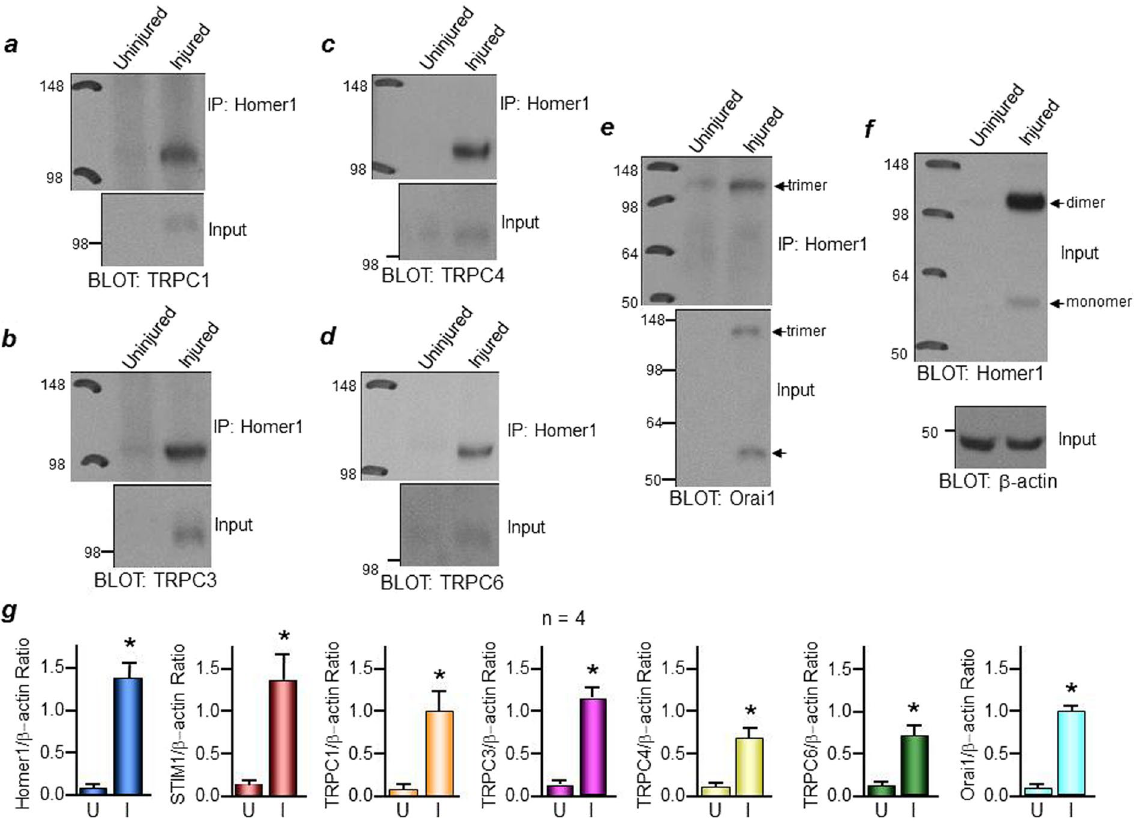
Figure 2. Increased protein expression and interaction of TRPC channels and Orai1 with Homer1 in neointima from balloon-injured rat carotid artery. Protein expression levels of Homer1 along with TRPC1, TRPC3, TRPC4, TRPC6, and Orai1 ( a – f ) are upregulated in injured (media + neointima) compared to uninjured VSMCs. Co-immunoprecipitation assay using anti-Homer1 antibody to immunoprecipitate Homer1 shows that Homer1 interacts with ( a ) TRPC1; ( b ) TRPC3; ( c ) TRPC4; ( d ) TRPC6; and ( e ) Orai1 in injured VSMCs. ( g ) Summary of protein expression normalized to β -actin in uninjured (U) and injured (I) VSMCs (n = 4). * p < 0.05 or better compared to uninjured